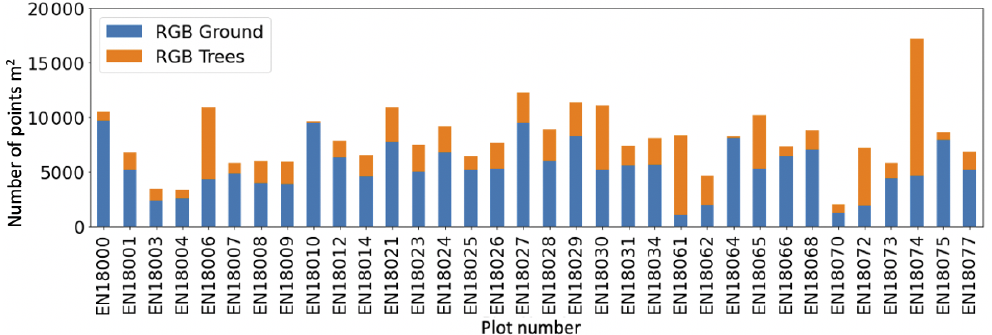
Figure 12. Ground and aboveground points per segmented point cloud per m 2